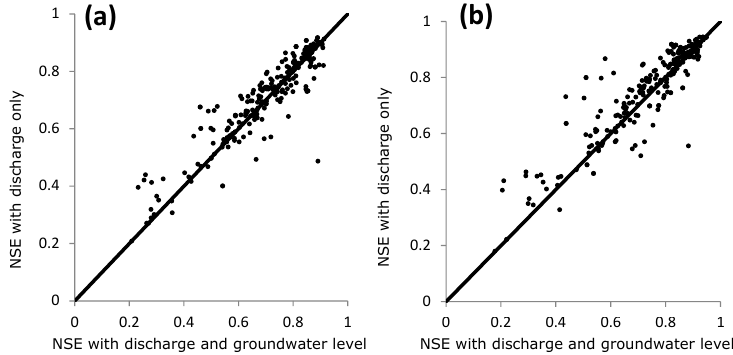
Figure 13. Comparison of NSE obtained with regression including only the discharge variable as a function of NSE obtained with discharge and groundwater-level variables in the 2011–2017 dataset with (a) the LLR model and (b) the LR